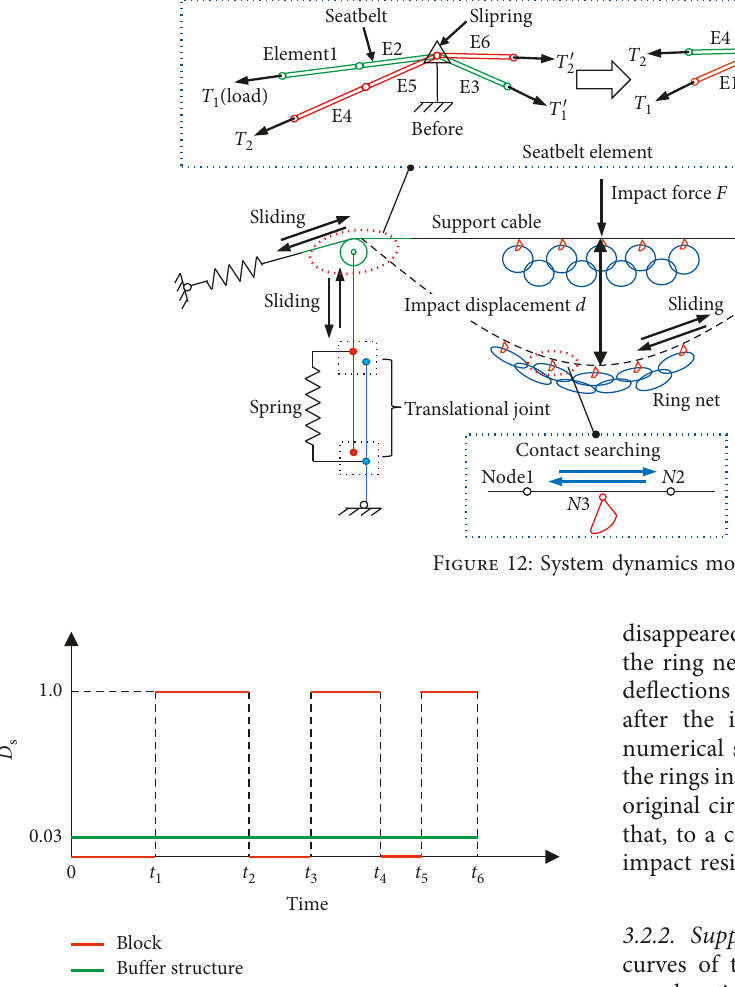
Figure 13: Time-varying mass weighted damping